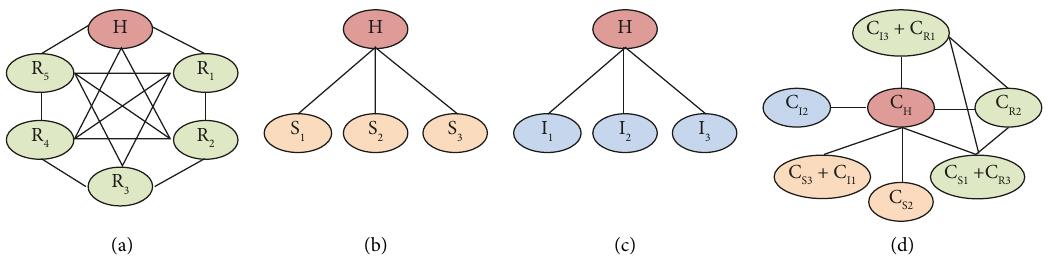
Figure 1: Network association model. networks: C, comprehensive; H, headquarters; I, investment; R: R & D; S, sales. (a) R & D network. (b) Sales network. (c) Investment network. (d) Comprehensive